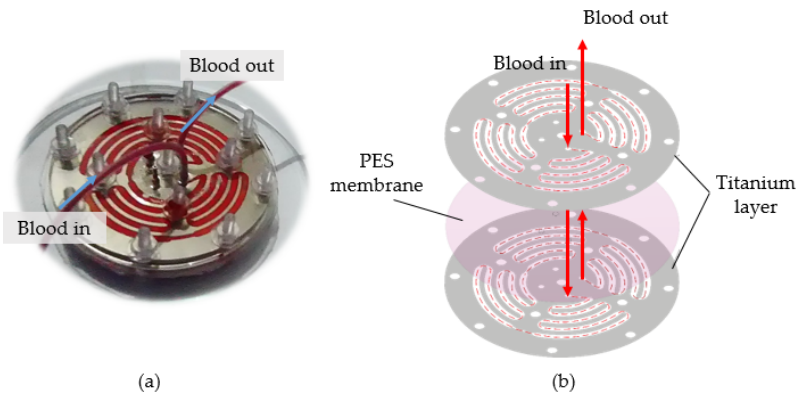
Figure 9. Fouling experiment. ( a ) Microfluidic channel; ( b ) structure of the microfluidic